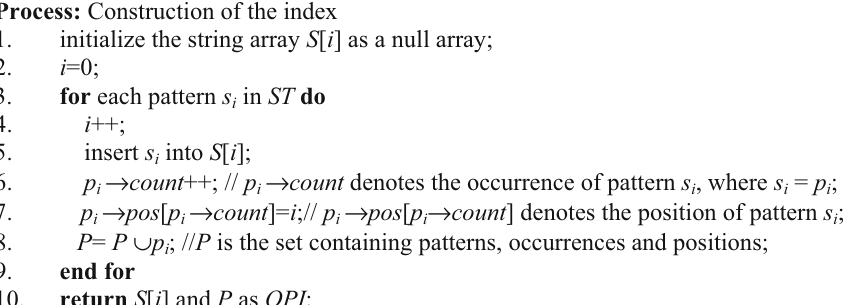
Fig. 2 Process of construction of the